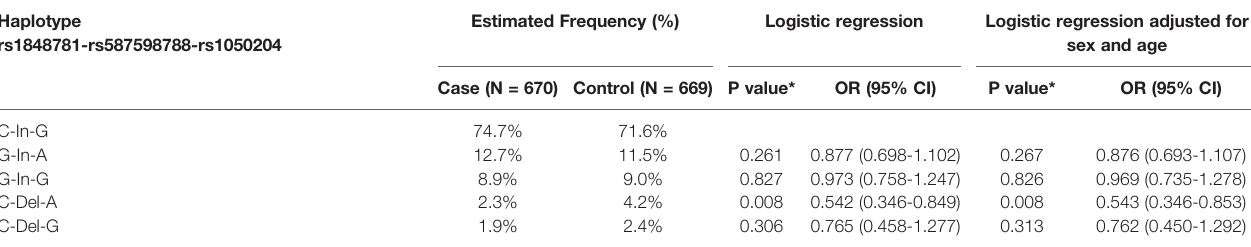
TABLE 3 | Association of FCGRIA variant haplotypes (rs1848781-rs587598788-rs1050204) with sarcoidosis